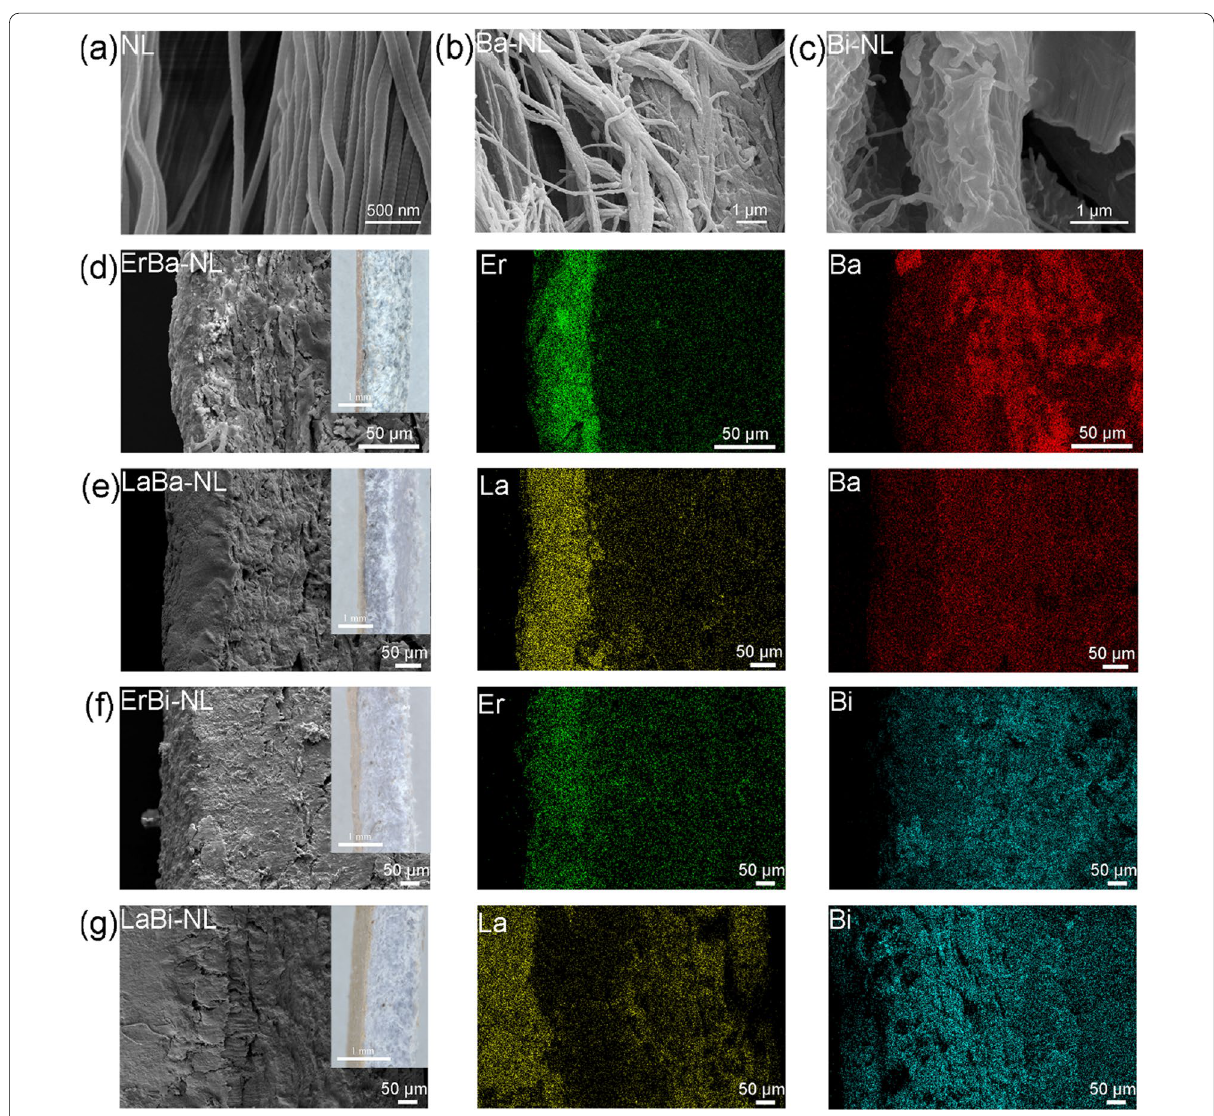
Fig. 2 SEM images and stereoscope photos of a NL; b Ba 5.46 -NL; c Bi 5.46 -NL; Cross-sectional SEM and Mapping images of d Er 0.32 Ba 5.46 -NL; e La 0.32 Ba 5.46 -NL; f Er 0.32 Bi 5.46 -NL; and g La 0.32 Bi 5.46